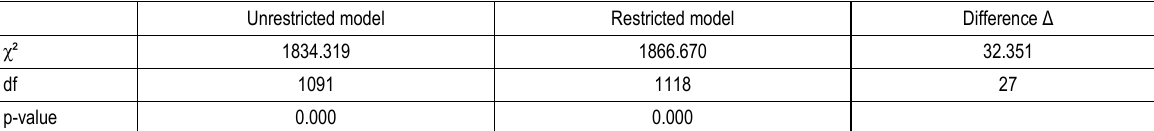
Table 3. Chi-square difference test for verifying the metric invariance